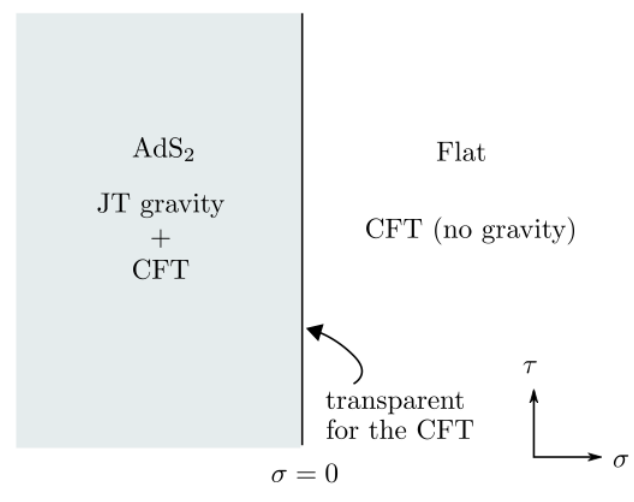
Figure 8 . We consider nearly- AdS 2 gravity with a matter CFT. The same CFT lives in an exterior (cid:13)at space with no gravity. We have transparent boundary conditions for the